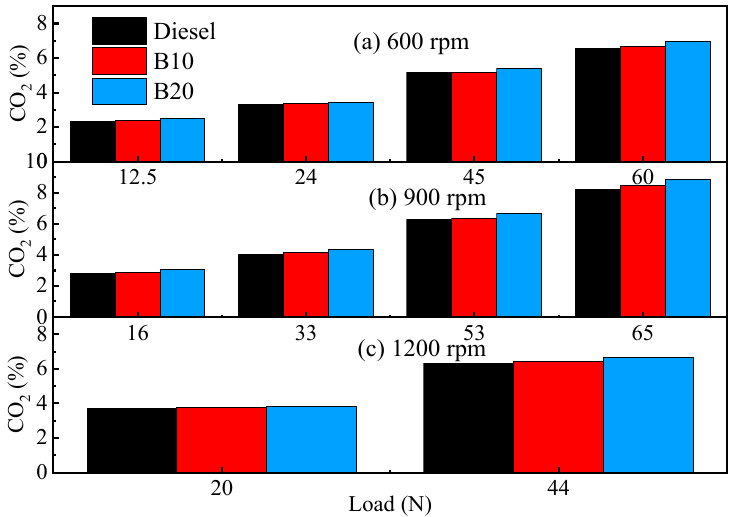
Figure 25. CO 2 emission comparison of biodiesel blends and diesel under different loads [197].